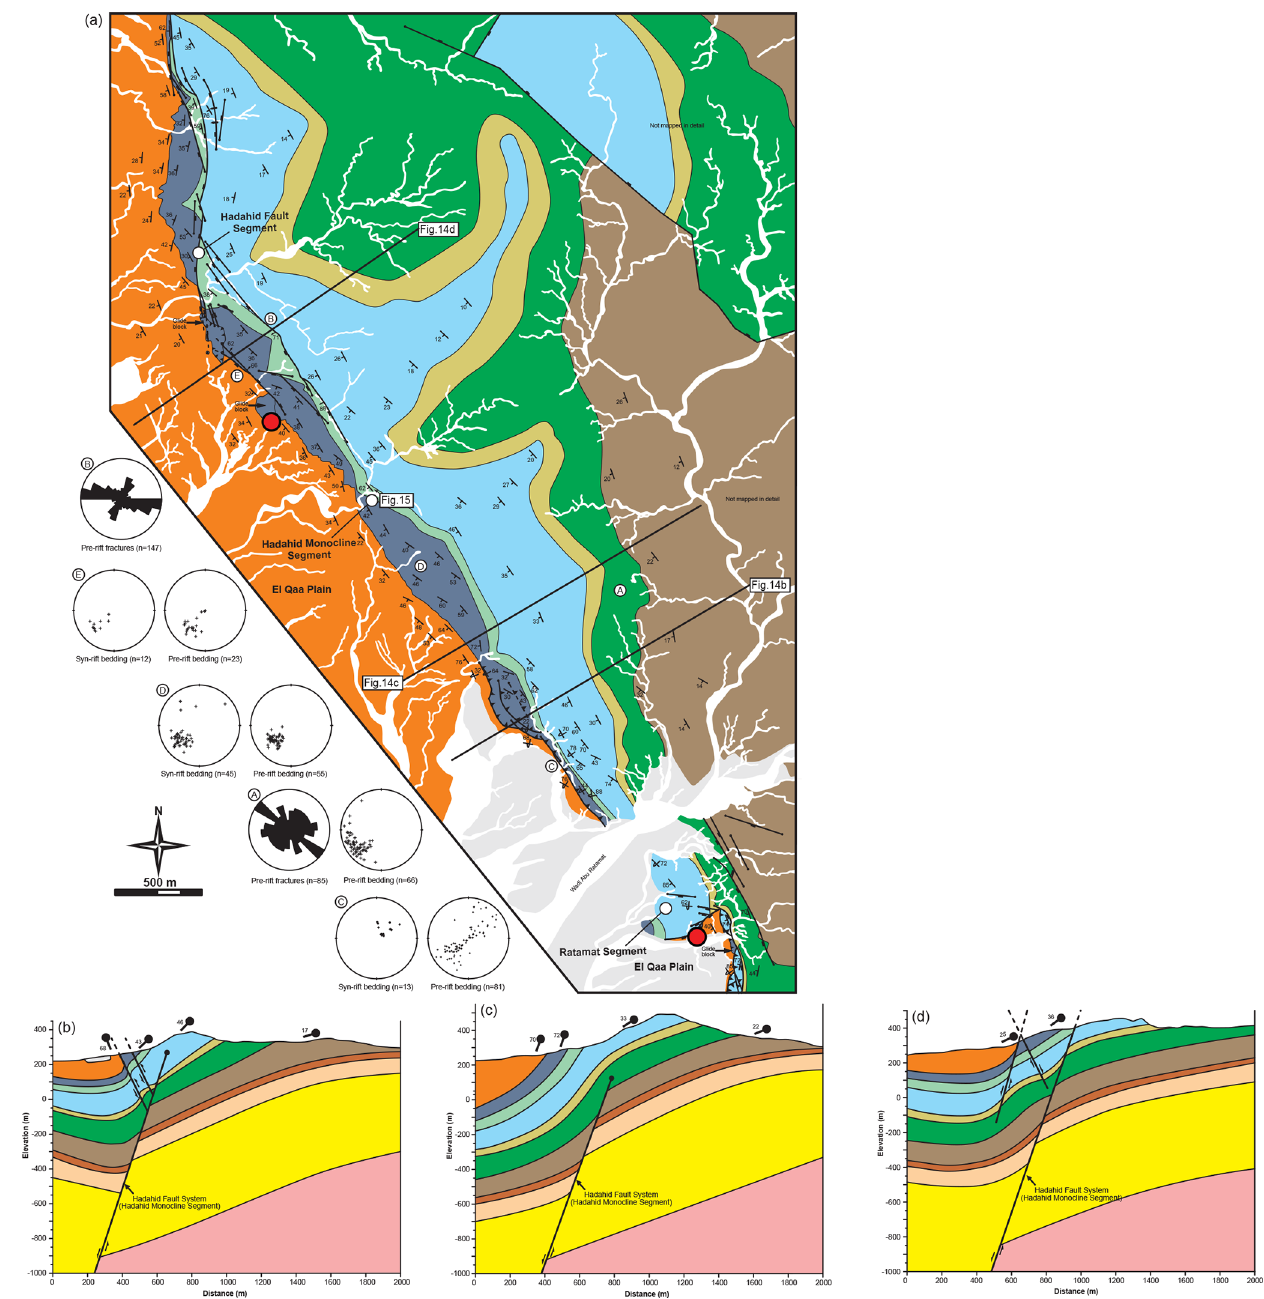
Figure 14. (a) Field map of the Hadahid Monocline and Hadahid fault (see also Fig. 16) segments of the Hadahid Fault System. Colour key to stratigraphic units is shown in Fig. 3a. Red dots indicate the approximate boundaries between the identified segments. Lower-hemisphere projection stereonets summarize the dip and dip direction of pre- and syn-rift bedding ( a–g ; location shown on map). Rose diagrams show the trend of fractures in pre-rift strata. The location of the photograph shown in Fig. 15 and the cross sections shown in (b) and (c) are indicated. (b) Down-plunge cross section across the central part of the Hadahid Monocline Segment. (c) Down-plunge cross section across the south-central part of the Hadahid Monocline Segment. (d) Down-plunge cross section across the southern part of the Hadahid Fault